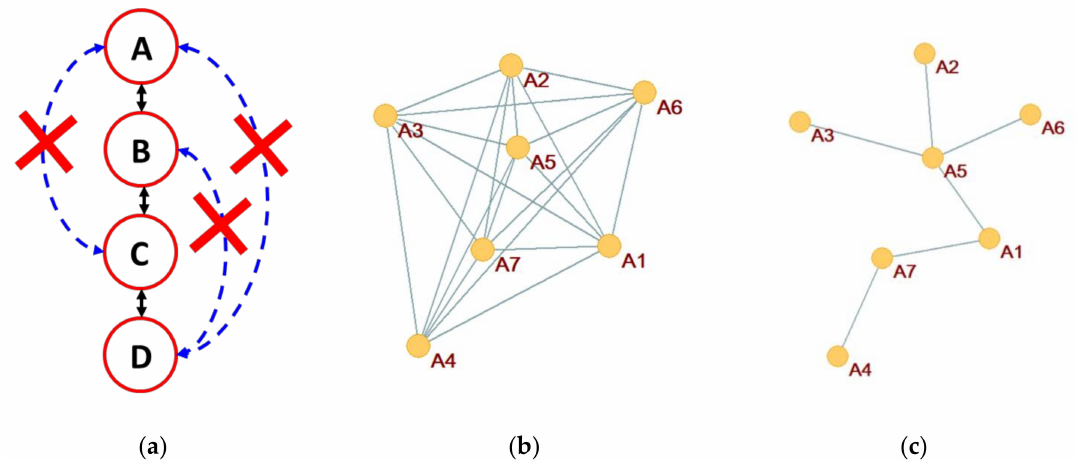
Figure 4. Examples of the data processing inequality. ( a ) A, B, C, and D are connected in a linear chain relationship. Although all six node pairs will likely have evidence of dynamical correlation, the DPI will infer the most likely path of information flow. For example, A-C will be eliminated because zI (A,B)> zI (A,C) and zI (B,C)> zI (A,C). B-D will be eliminated because zI (B,C)> zI (B,D) and zI (C,D)> zI (B,D). A-D will be eliminated in two ways: first, because zI (A,B)> zI (A,D) and zI (B,D)> zI (A,D), and then because zI (A,C)> zI (A,D) and zI (C,D) > zI (A,D). ( b ) An example of a zI -graph, and ( c ) the same graph in which epiphenomenal links have been removed (a “ zI-graph_dpi ”). In this case the underlying network of relationships is a